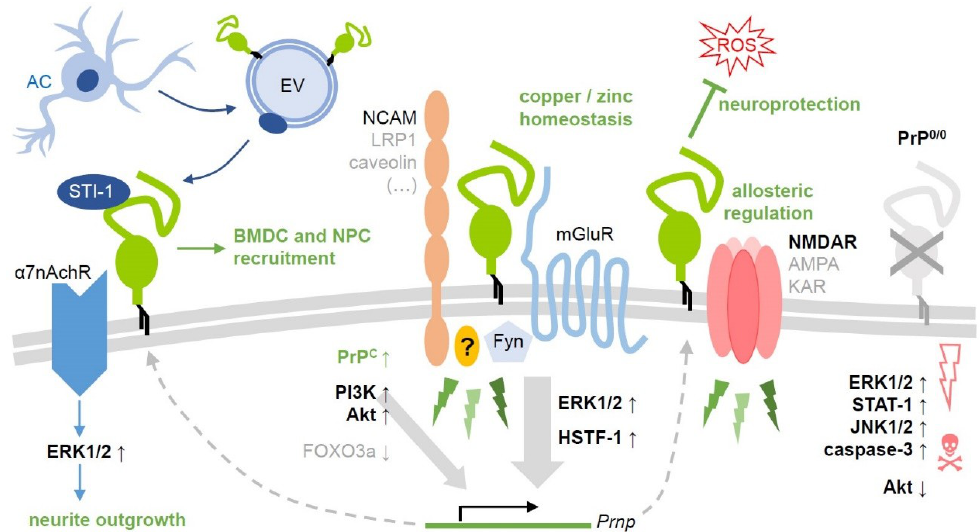
Figure 1. Selected PrPC-related signaling pathways and their (potential) relevance after ischemic insults. As a GPI-anchored protein, PrPC (center, green) is unable to transmit signals into the cell. To do so, it forms cell type- and context-dependent complexes with various transmembrane (NCAM, LRP1, caveolin, subunits of mGluR, NMDA, AMPA, kainate, or a7nAch receptors) and cytosolic signaling proteins. This allows for its involvement in a variety of signaling events (green thunderbolts) with diverse functional outcome. Some of those have been investigated in detail, while others remain rather poorly defined. Here, only a few cascades with (likely) implications in stroke are depicted (with no claim to be complete). These are mostly associated with neuroprotective and regenerative processes in the penumbra following ischemic damage. Note that small upward arrows next to the protein names indicate upregulation/activation, whereas downward arrows stand for downregulation/inhibition (ROS: Harmful reactive oxygen species). Some factors, such as the MAP kinase ERK1/2, may play a dual role causing both beneficial and detrimental effects (e.g., in PrP0/0 mice, on the very right), depending on the exact region, cell type, and time point after damage induction as well as on the experimental paradigm. Activation of the protein Akt has so far mostly been associated with protective effects in this context. Intercellular communication is of utmost importance in regenerative processes after stroke, as exemplified here by the co-chaperone STI-1, which is released (possibly in association with extracellular vesicles, EV) by astrocytes and binds to cell surface PrPC. Consequences of this interaction may include recruitment of bone marrow-derived (BMDC) and neural precursor cells (NPC) to the damaged brain region as well as neurite outgrowth. References given in the main text.